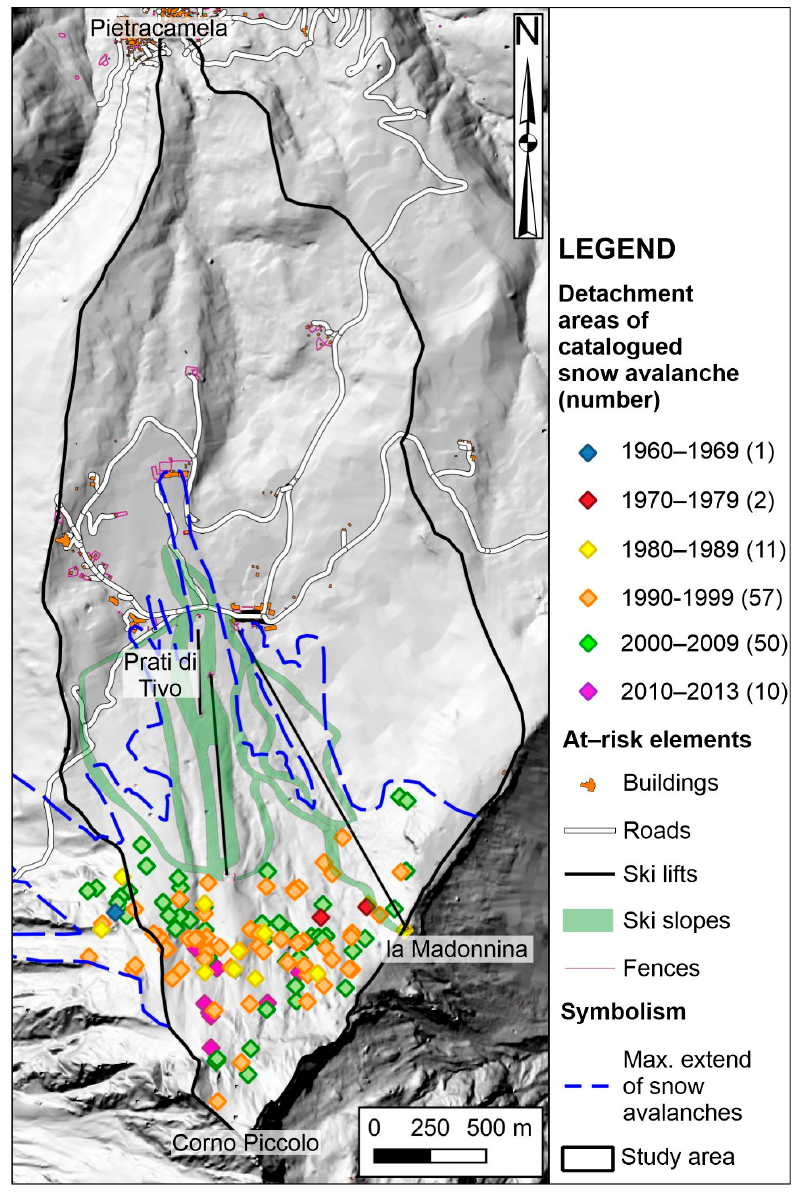
Figure 12. Historical snow avalanche map of the study area (1957–2013 period).